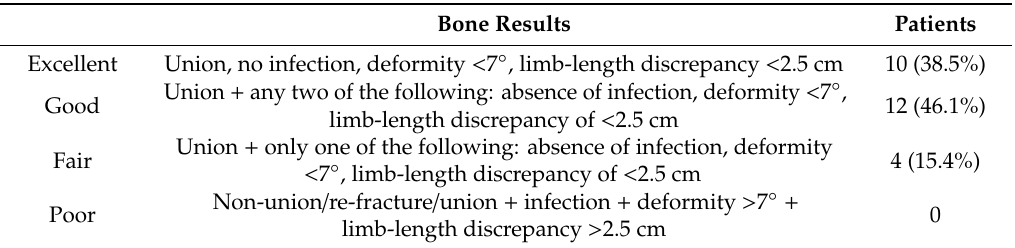
Table 1. Bone results according to ASAMI Scoring